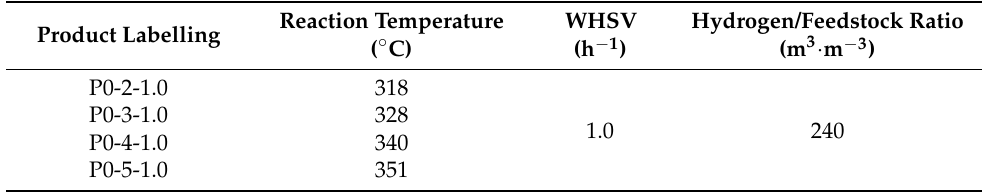
Table 13. The reaction conditions and labelling of the products obtained by hydrotreating the F0